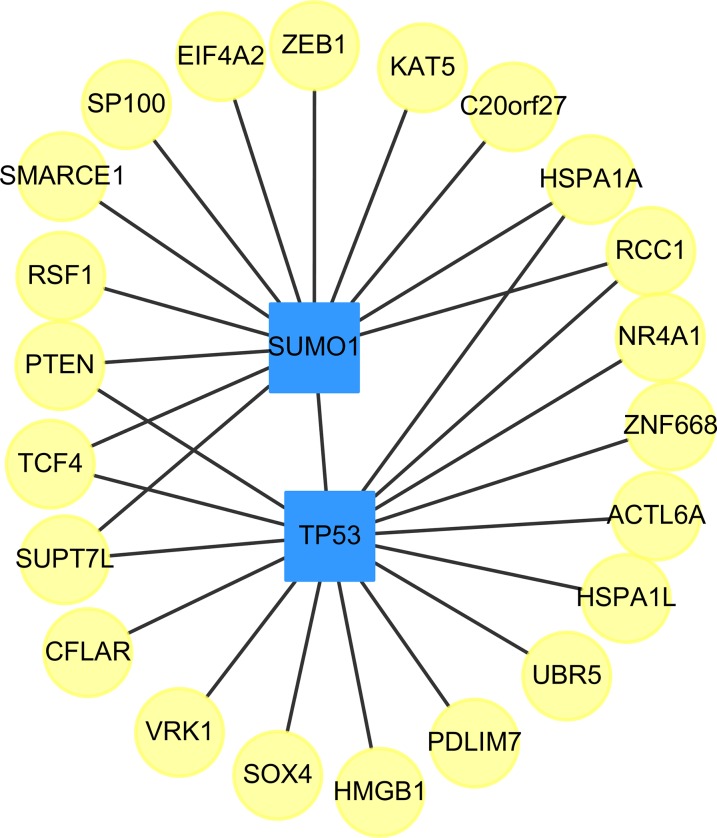
The top two genes (squares) which connect to the largest and the second largest degree of targeted genes (circles) in the down-regulated CVDs PPI after cluster analysis.